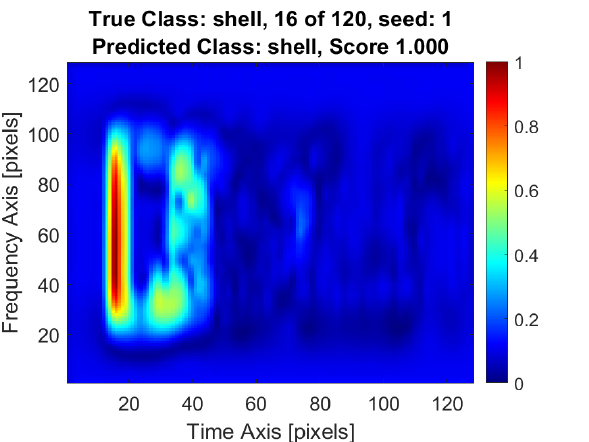
Figure 10. Grad-CAM heat map for the CNN trained on spectrograms to discriminate between shell and solid, generated from the same test image in Figure